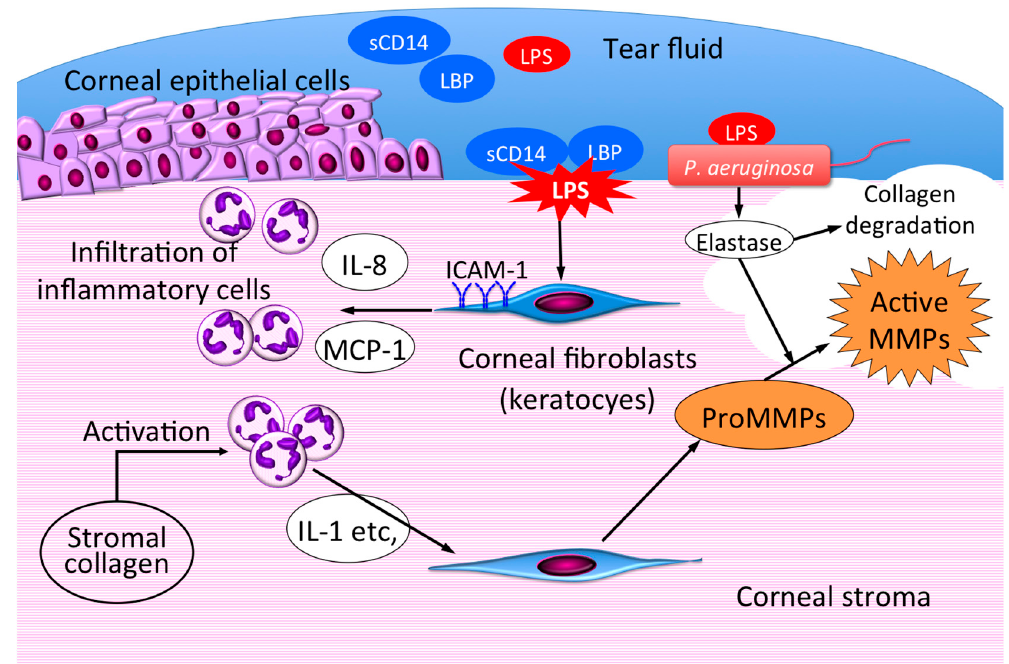
Figure 7. Role of corneal fibroblasts in bacterial keratitis. LPS released from bacteria binds to LBP and sCD14 in tear fluid, and the LPS-LBP-sCD14 complex then activates corneal fibroblasts. The activated fibroblasts promote inflammatory cell recruitment through expression of chemokines and adhesion molecules. Infiltrated neutrophils are activated by corneal stromal collagen and secrete inflammatory mediators including IL-1 that stimulate pro-MMP secretion by fibroblasts. The released pro-MMPs are activated by bacterial proteases such as Pseudomonas aeruginosa elastase, and the active MMPs then degrade stromal collagen, leading to corneal melting.